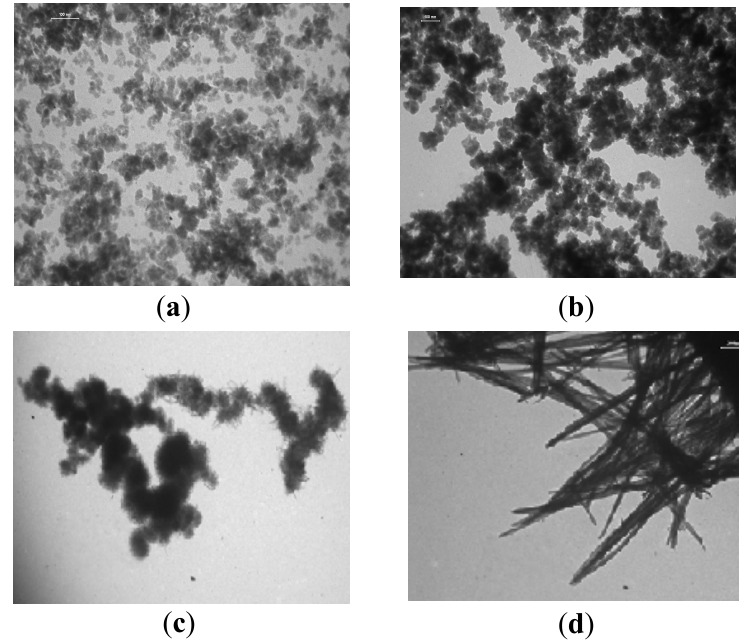
Figure 2. TEM images for the 1S-Mn ( a ); 2S-Mn ( b ); 3S-Mn ( c ); and 6S-Mn ( d ) samples.